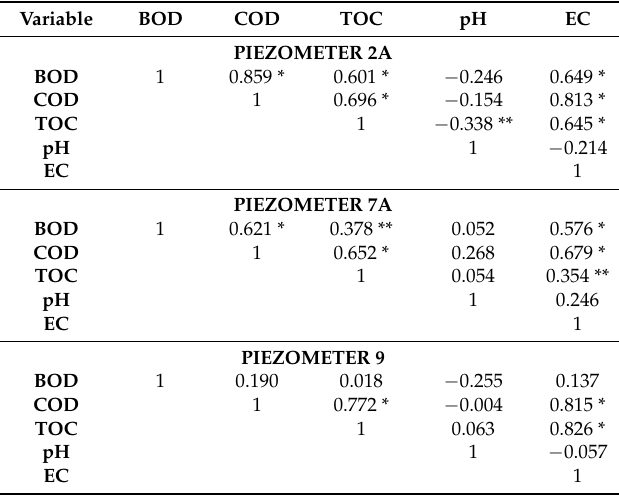
Table 4. Pearson’s correlation analysis between selected pollution indicators based on monitoring data from piezometers located within the landfill area. Variable